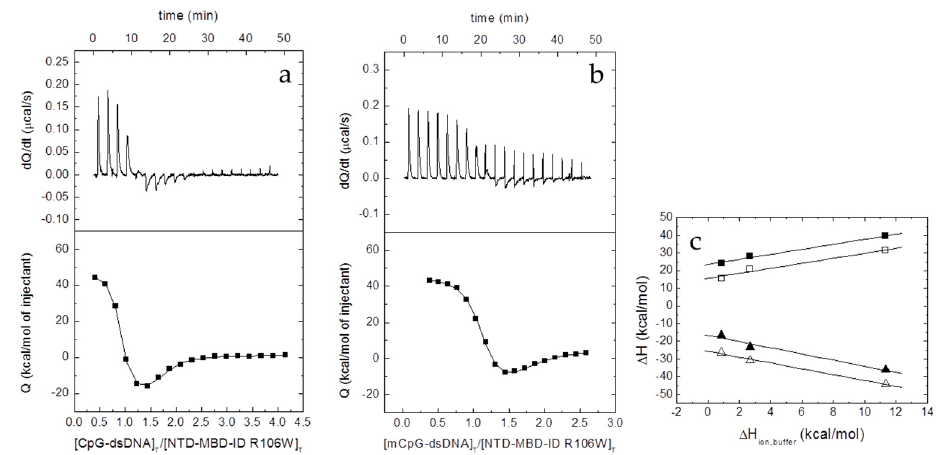
Figure 5. Interaction of the NTD-MBD-ID R106W with unmethylated CpG-dsDNA ( a ) and methylated mCpG-dsDNA ( b ) by ITC in Tris 50 mM, 20 ° C, pH 7. Upper plots show the thermogram (raw thermal power as a function of time) and the lower plots show the binding isotherm (ligand-normalized heat effects as a function of the molar ratio). Non-linear least-squares analysis using a two binding sites model allowed estimating the observed binding affinity and enthalpy (continuous lines). ( c ) Equation (2) was employed for estimating the buffer-independent binding enthalpy for both sites (high affinity, squares; low affinity, triangles) for CpG-dsNA (open symbols) and mCpG-dsDNA (closed symbols). From linear regression, the intercept with the y -axis (observed enthalpy extrapolated at zero buffer ionization enthalpy) provides the buffer-independent interaction enthalpy Δ H , and the slope provides Δ n H .